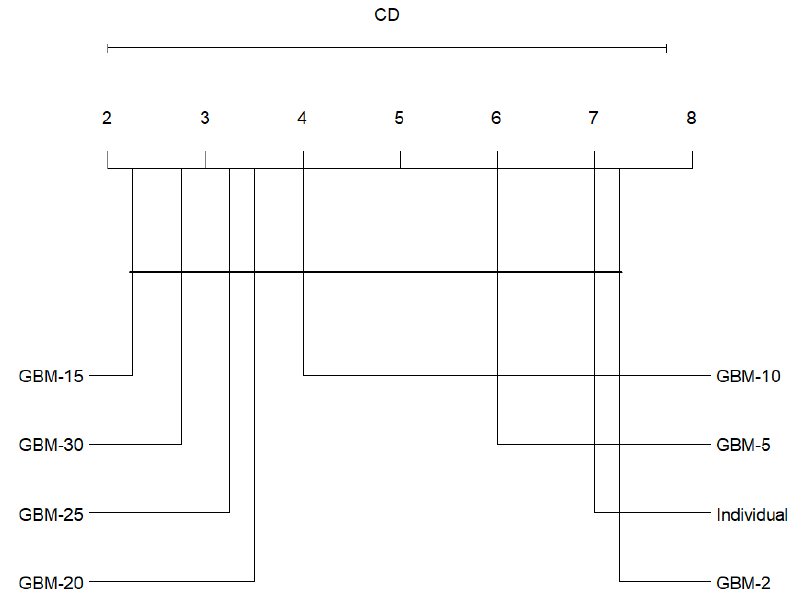
Figure 3. Critical difference plot based on Nemenyi test with respect to MCC metric. Critical difference (CD) is at 5.74, which exceeds the average rank, while all classifiers are tied